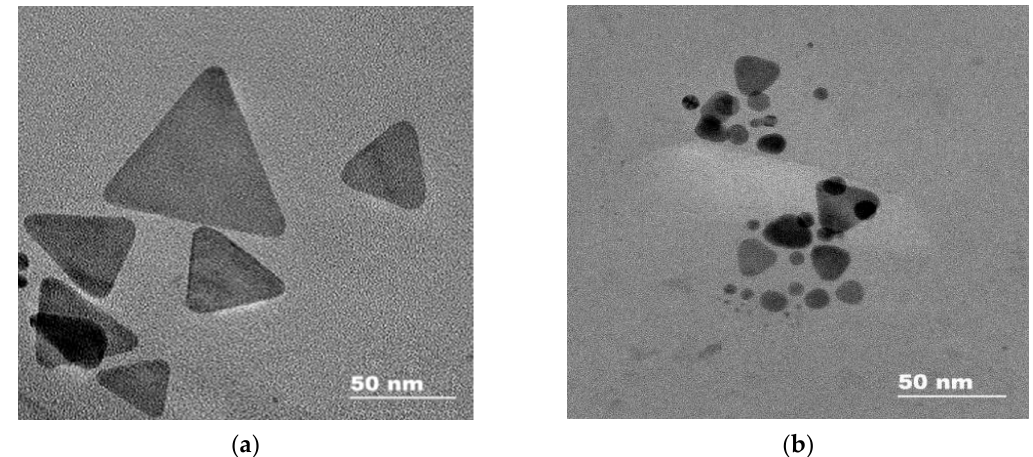
Figure 1. A TEM image of silver triangular nanoplates (AgTNPs) before ( a ) and after ( b ) the interaction with hydrogen peroxide. c (AgTNPs) = 0.16 mM Ag, c (HP) = 30 μ M, pH 6.